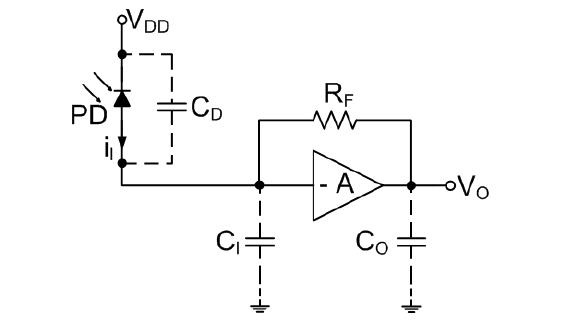
Figure 4. Basic configuration of the shunt-feedback